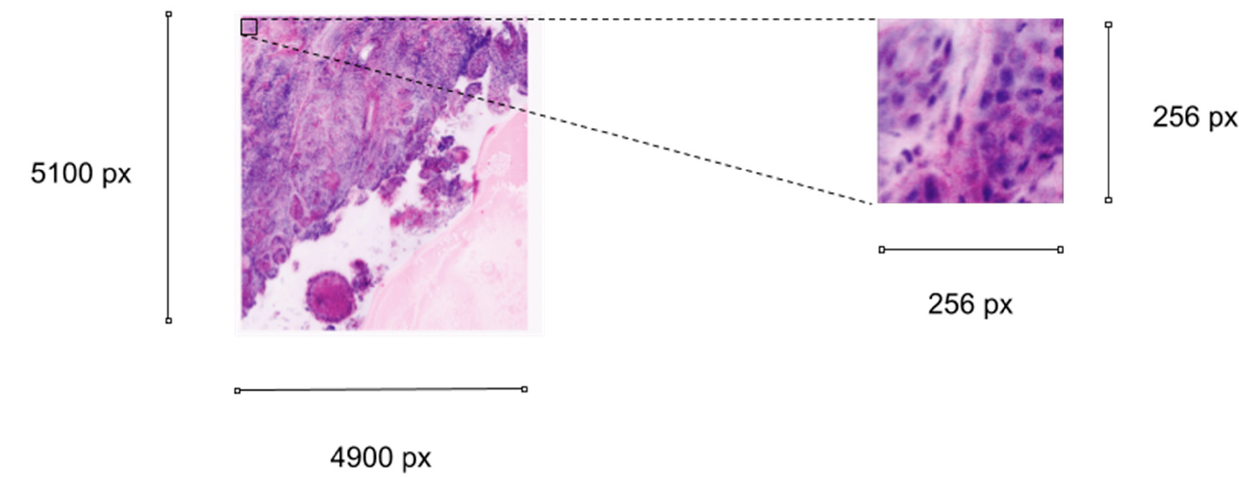
Figure 1. An example of an ex vivo FCM scan with a 256 × 256 px input image.